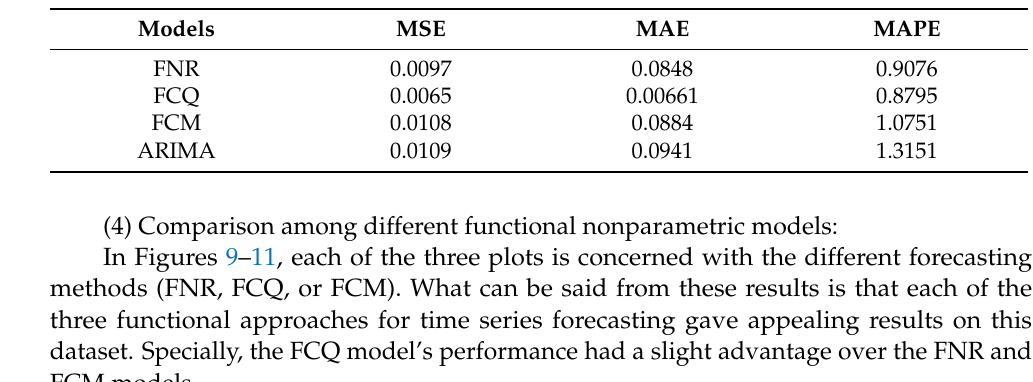
Table 6. The results of forecasting errors for different models.